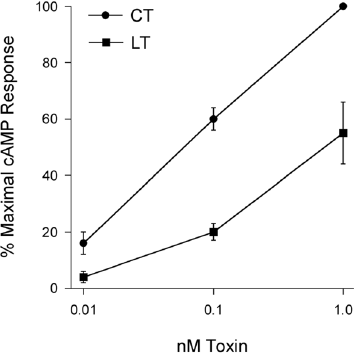
Figure 2. Comparative analysis of CT/LT potency. CHO cells were incubated with 0.01 nM, 0.1 nM, or 1.0 nM CT or LT for 2 h before cAMP levels were quantified. Data are expressed as percentages of the maximal cAMP response for the assay and are presented as mean ± standard error of six independent experiments with triplicate samples.